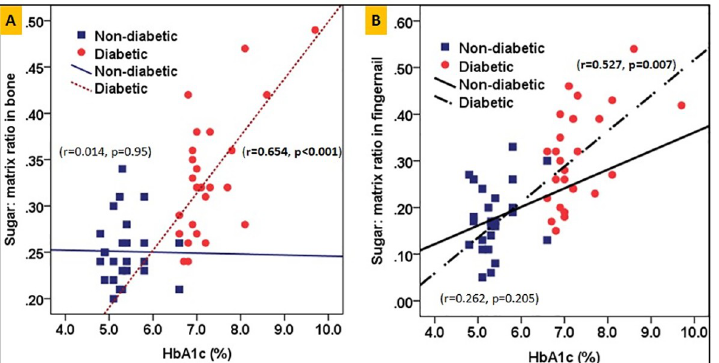
Fig 6. Correlation between HbA1c and the sugar-to-matrix ratio for both bone and fingernail are shown in 6(A) and 6 (B) respectively for diabetic and non-diabetics